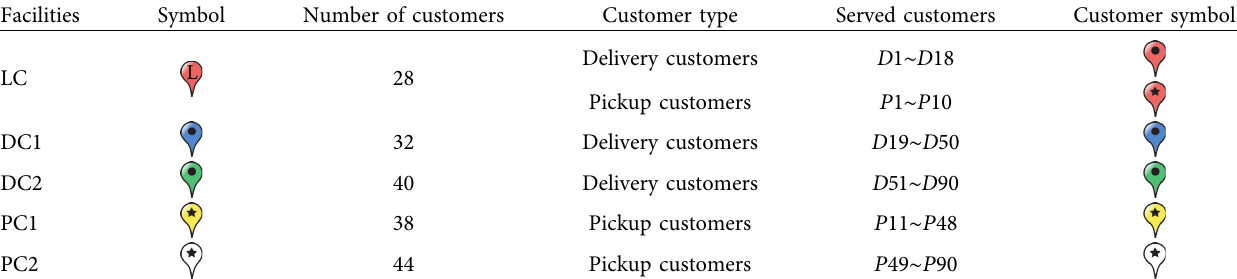
Table 7: The characteristics of the LC, DCs, PCs, and customers.